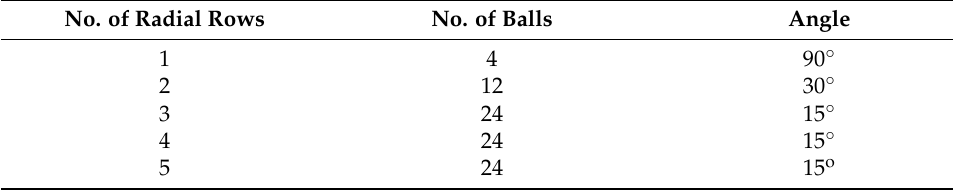
Figure 3. Model no. 2 for the damper with 2040 balls. Table 1. The geometry of balls. N = 1320 balls. No. of Radial Rows Table 2. The geometry of balls. N = 2040 balls.